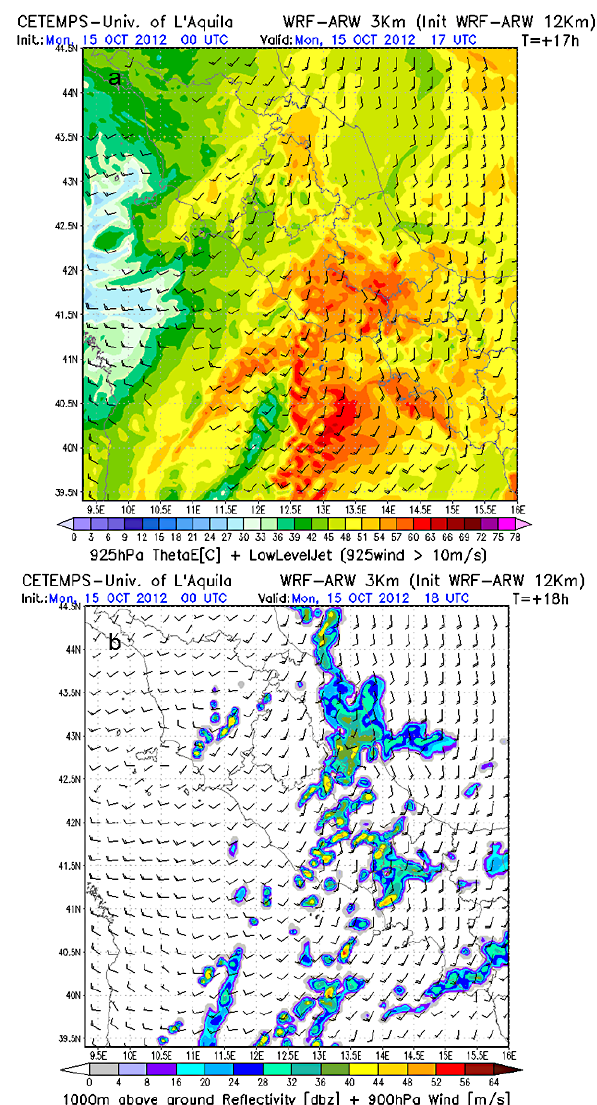
Figure 13. Falcon 20 flight on 15 October 2012 (18:00UTC to 21:00UTC): (a) reflectivity; (b) flight track. Courtesy of Julien De- lanoe (LATMOS/IPSL/UVSQ, France).